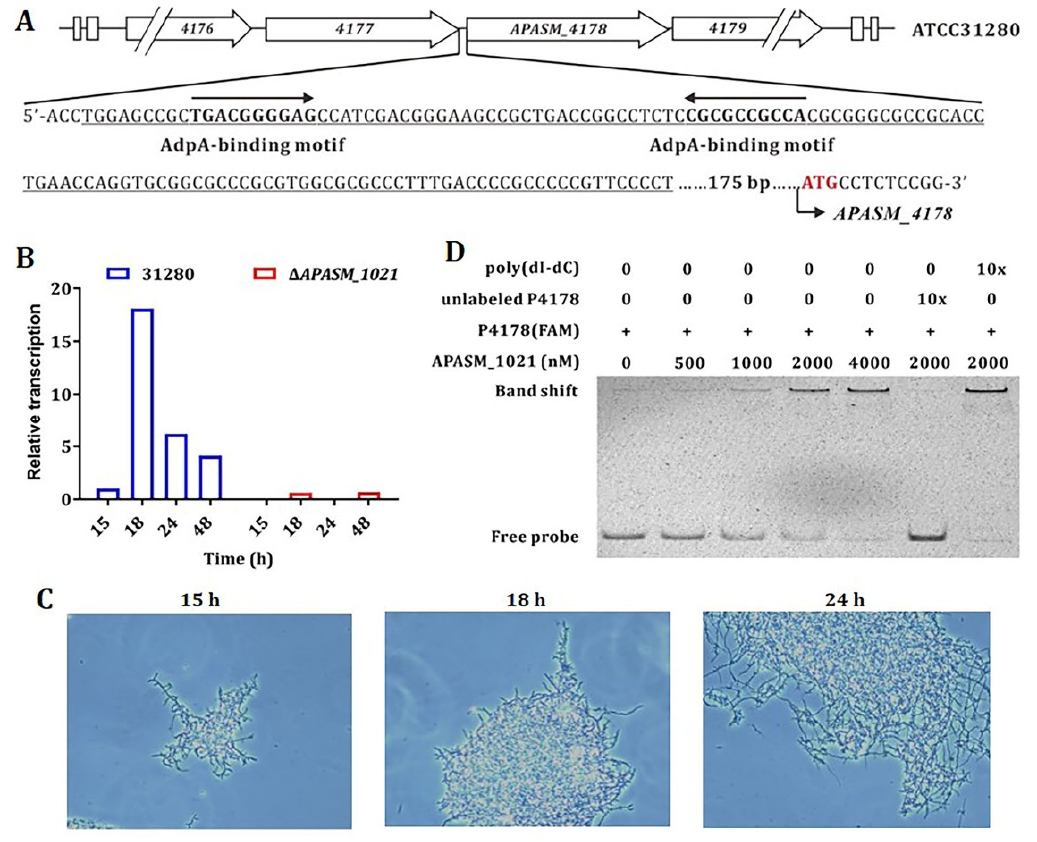
Figure 3. The transcription of APASM_4178 is regulated by an AdpA-like protein APASM_1021. ( A ) Conserved AdpA-binding motifs in the upstream region of APASM_4178 . Underlined sequences refer to the 131-bp region covered by P4178, the 5 ʹ -FAM-labeled probe for electrophoretic mobility shift assay (EMSA). The start codon of APASM_4178 is shown in red; ( B ) The transcription of APASM_4178 in the wild-type and the APASM_1021 -deleted mutant WYT-15. The transcription level of APASM_4178 in the wild-type at 15 h is set as 1; ( C ) Phase-contrast micrographs of the APASM_1021 -deleted mutant WYT-15. Scale: 5 µ m. Magnification, 400 × . ( D ) EMSA of the specific binding between the upstream region of APASM_4178 and purified APASM_1021. P4178 is a 131-bp 5 ʹ -FAM-labeled probe.